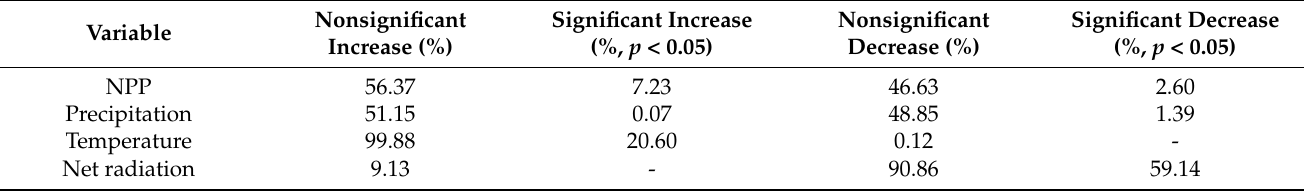
Table 4. Drought-affected area in Mongolia over the period 2003–2018. The percentage number (unit: %) indicates the drought-affected area.